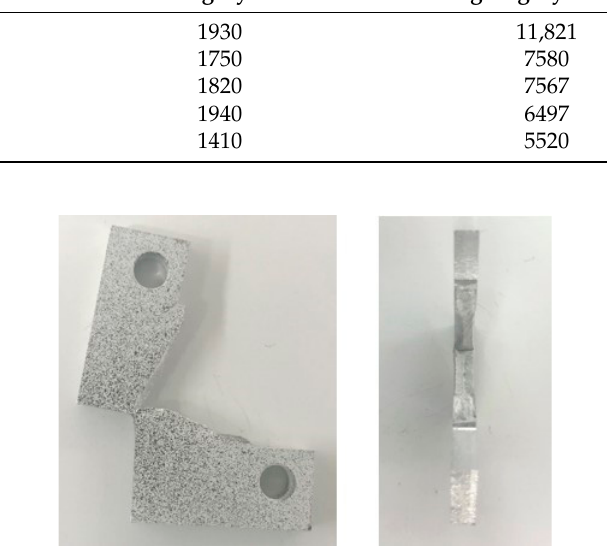
Figure 9. Failed specimen.